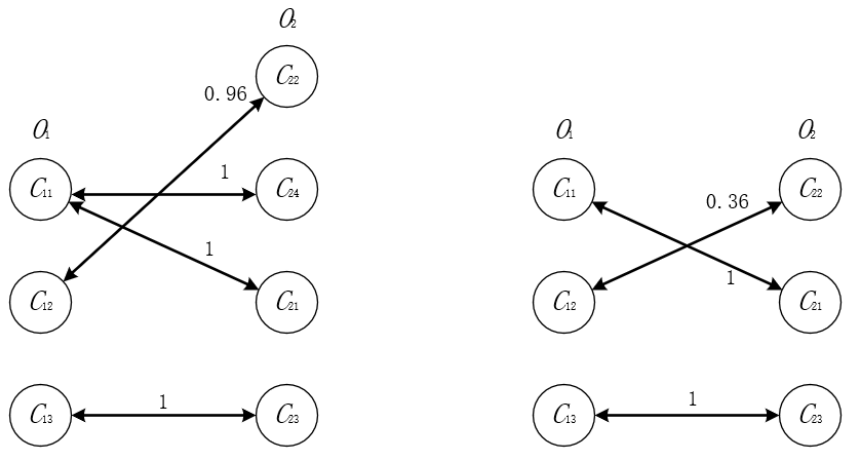
Figure 6. The Examples of Irrationality